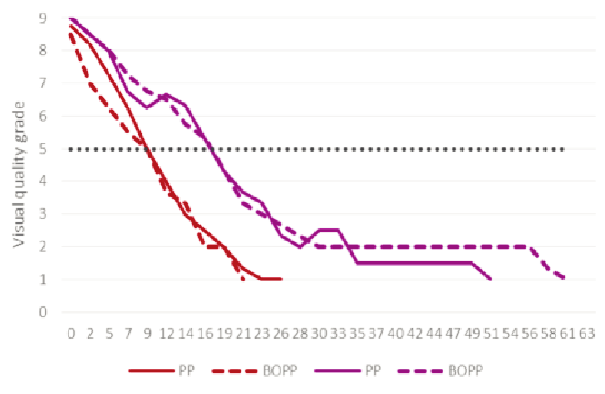
Fig. 3 ­ Trend of visual quality during storage for B. semperflo‐ rens (red) and V. cornuta (purple). Data are shown as mean values. The intersection of the curves with the dot­ ted horizontal line corresponds to the marketability limit (grade 5). PP= plastic box + lid; BOPP= Plastic box without its lid, inserted into a bi­oriented polypropylene plastic